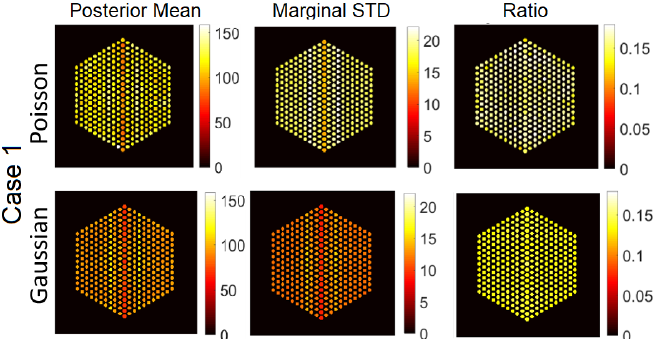
Figure 16. The FULL response matrix: pin pixels, averaging of the proposed approach for Case 1 “Full assembly”. ( Left-hand column ): posterior mean; ( middle column ): marginal standard deviation; and ( right-hand column ): the ratio of marginal standard deviation divided by posterior